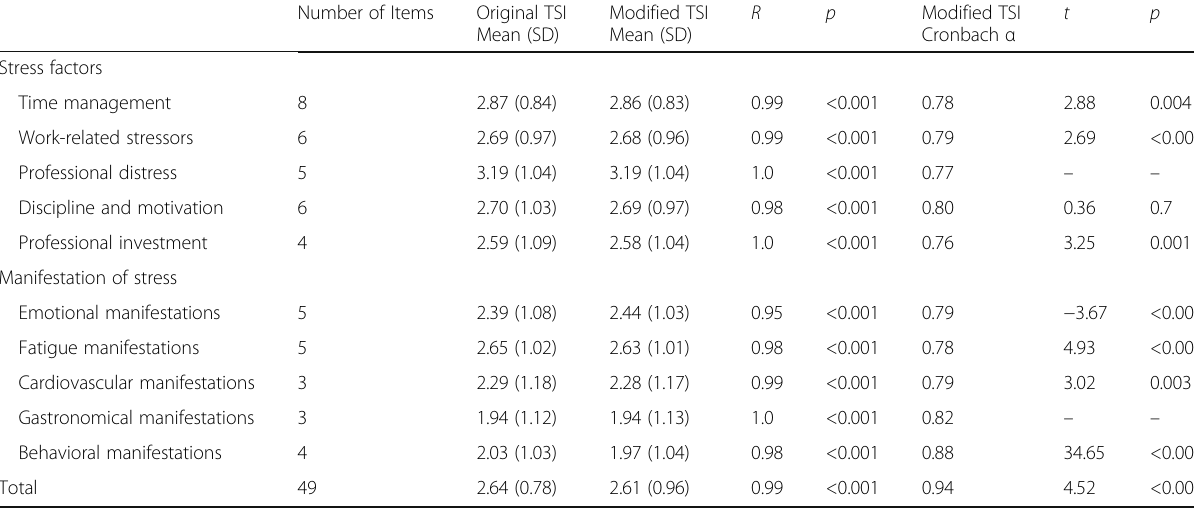
Table 3 Concurrent validity of the items of the original TSI and the modified TSI Number of